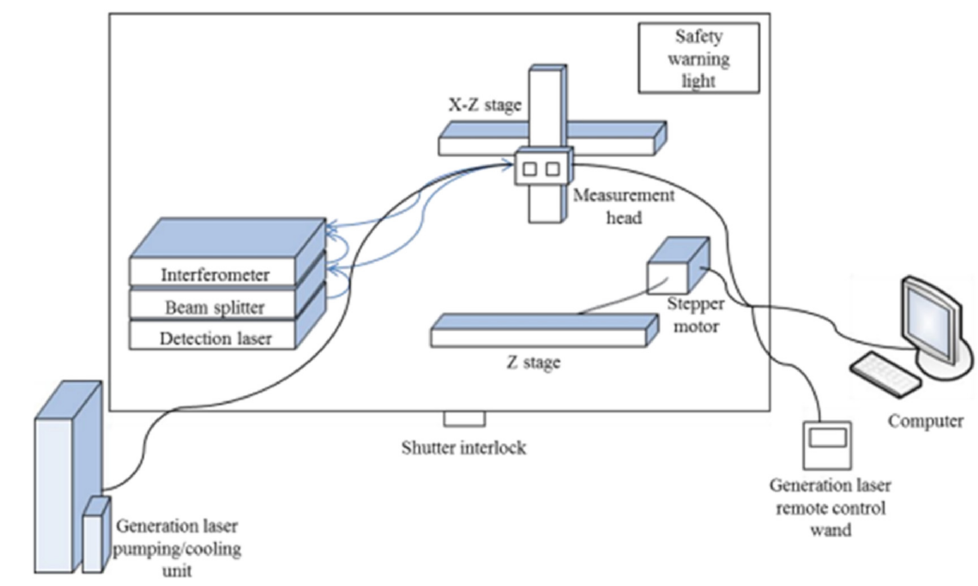
Figure 13. Schematic of laser ultrasound testing equipment set